Question: Which kind of chart has been used to present this data?
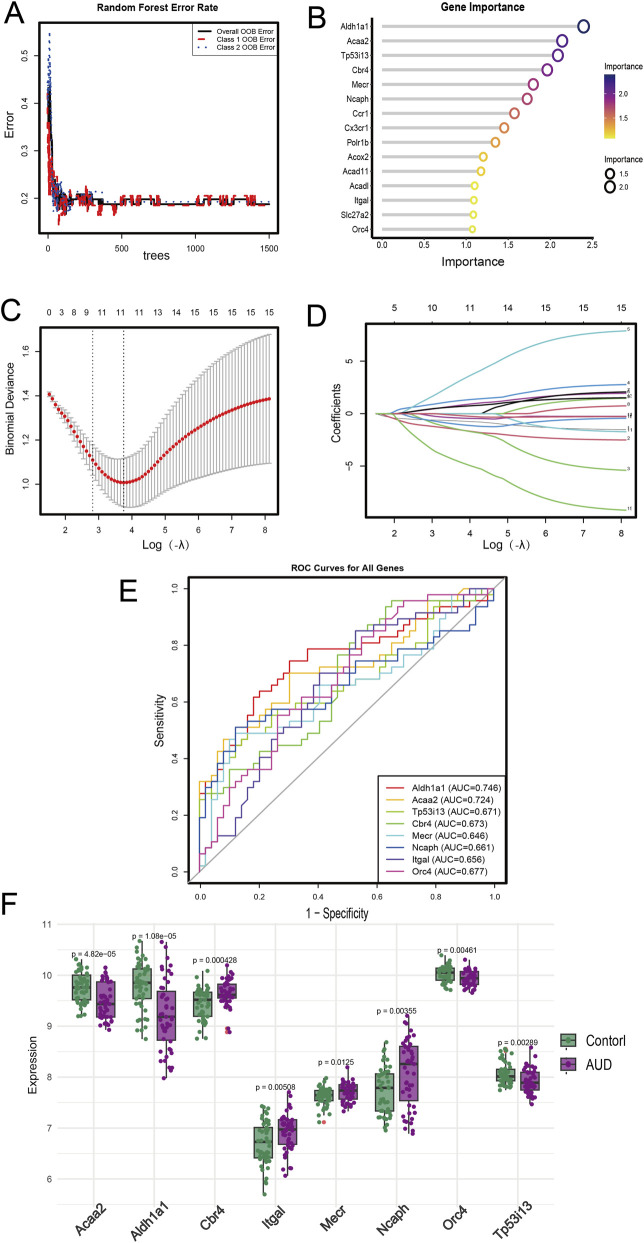
Answer: box